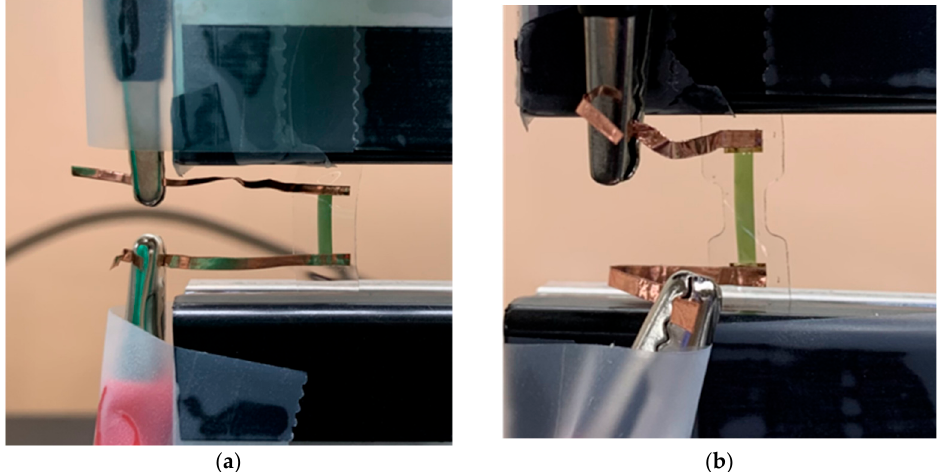
Figure 3. Measuring electrical properties. ( a ) Sample A (PANI strain sensor), ( b ) Sample B (PANI/Au strain sensor), and Sample C (PANI/Au/H-PDMS strain sensor).